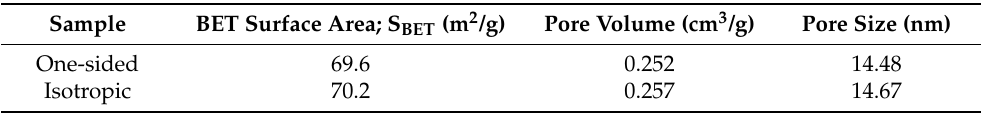
Table 1. Brunauer–Emmet–Teller (BET) results of the V 2 O 5 -WO 3 /TiO 2 prepared by the one-sided heating and isotropic heating